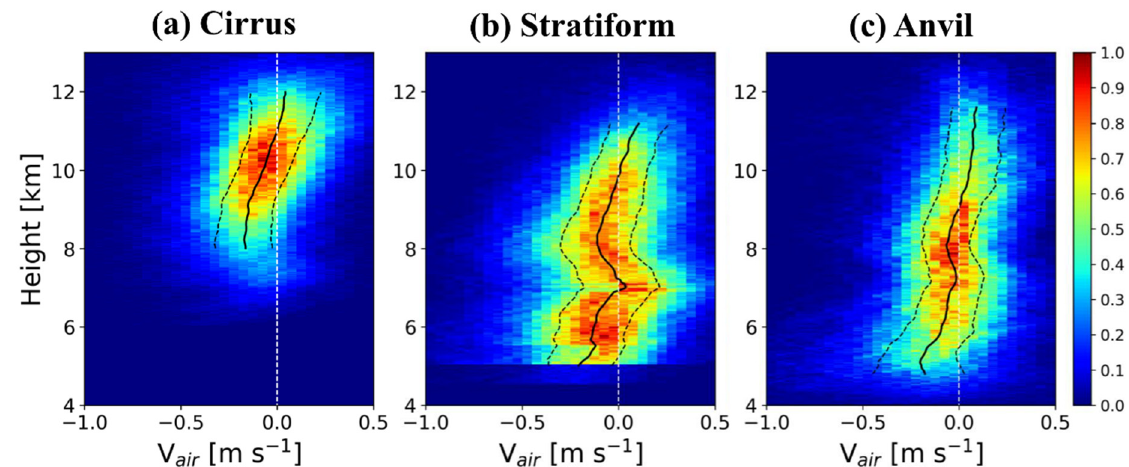
Figure 15. Contoured frequency by altitude diagrams (CFADs) of V air for different ice cloud types: ( a ) cirrus, ( b ) stratiform, and ( c ) anvil cases. The median and quantiles (25% and 75%) are shown in the solid and dashed lines.